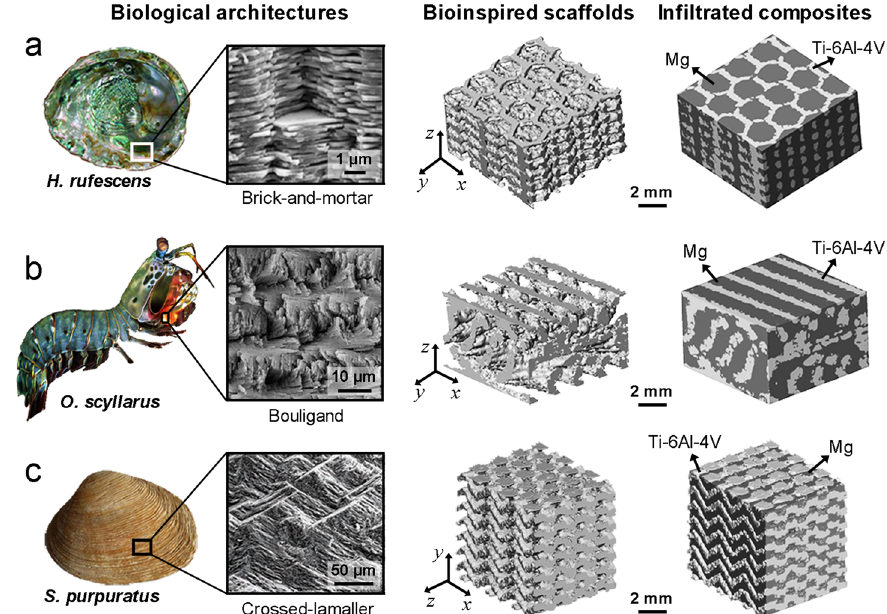
Fig. 1 Bioinspired architectures of 3-D printed Ti-6Al-4V scaffolds and their in fi ltrated Mg-Ti composites. The structures of representative biological prototypes in Nature, respectively the shell of abalone H. rufescens 36 , the dactyl club of mantis shrimp O. scyllarus 38 , and the shell of bivalve mollusk S. purpuratus 40 for the ( a) brick-and-mortar, b Bouligand, and c crossed-lamellar architectures, are also presented for comparison. The architectures of the scaffolds are manifested using the 3-D XRT micrographs of the composites by fi ltering out the signals of Mg. The micrographs for the structures of biological materials are adapted with permission from refs. 36,38,40 . Panel a adapted (with permission) from ref. 36 . Panel b adapted (with permission) from ref. 38 . Panel c adapted (with permission) from ref. 40